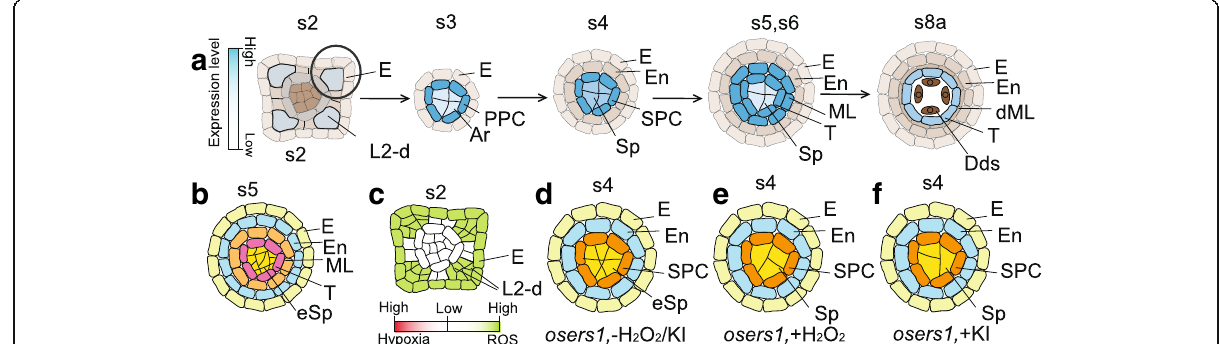
Fig. 4 OsERS1 is required for redox regulation. a Expression pattern of OsERS1 in anther, b osers1 anther at stage 5 with excess Sp cells, c Higher ROS level in osers1 anthers at stage 2, d-f osers1 anthers at stage 4 treated with H 2 O 2 or KI, d osers1 anther without treatment, e osers1 anther treated with H 2 O 2 , f osers1 anther treated with KI. Blue color in a shows the gradients of gene expression; grey color in a shows different cell layers without OsERS1 expression; green color in c shows the gradient of ROS level; white color in c shows no detectable redox